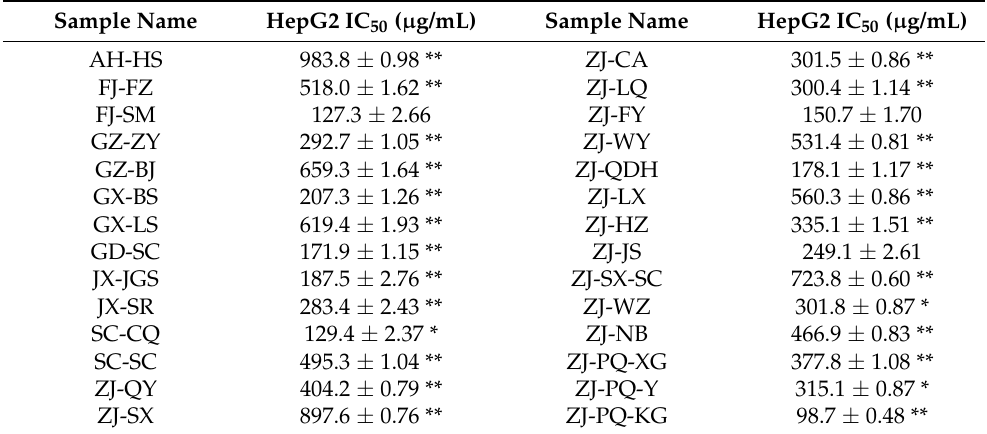
Table 1. IC 50 of growth inhibition of HepG2 tumor cells by T. hemsleyanum of different origins ( n = 3, * p < 0.05, ** p <